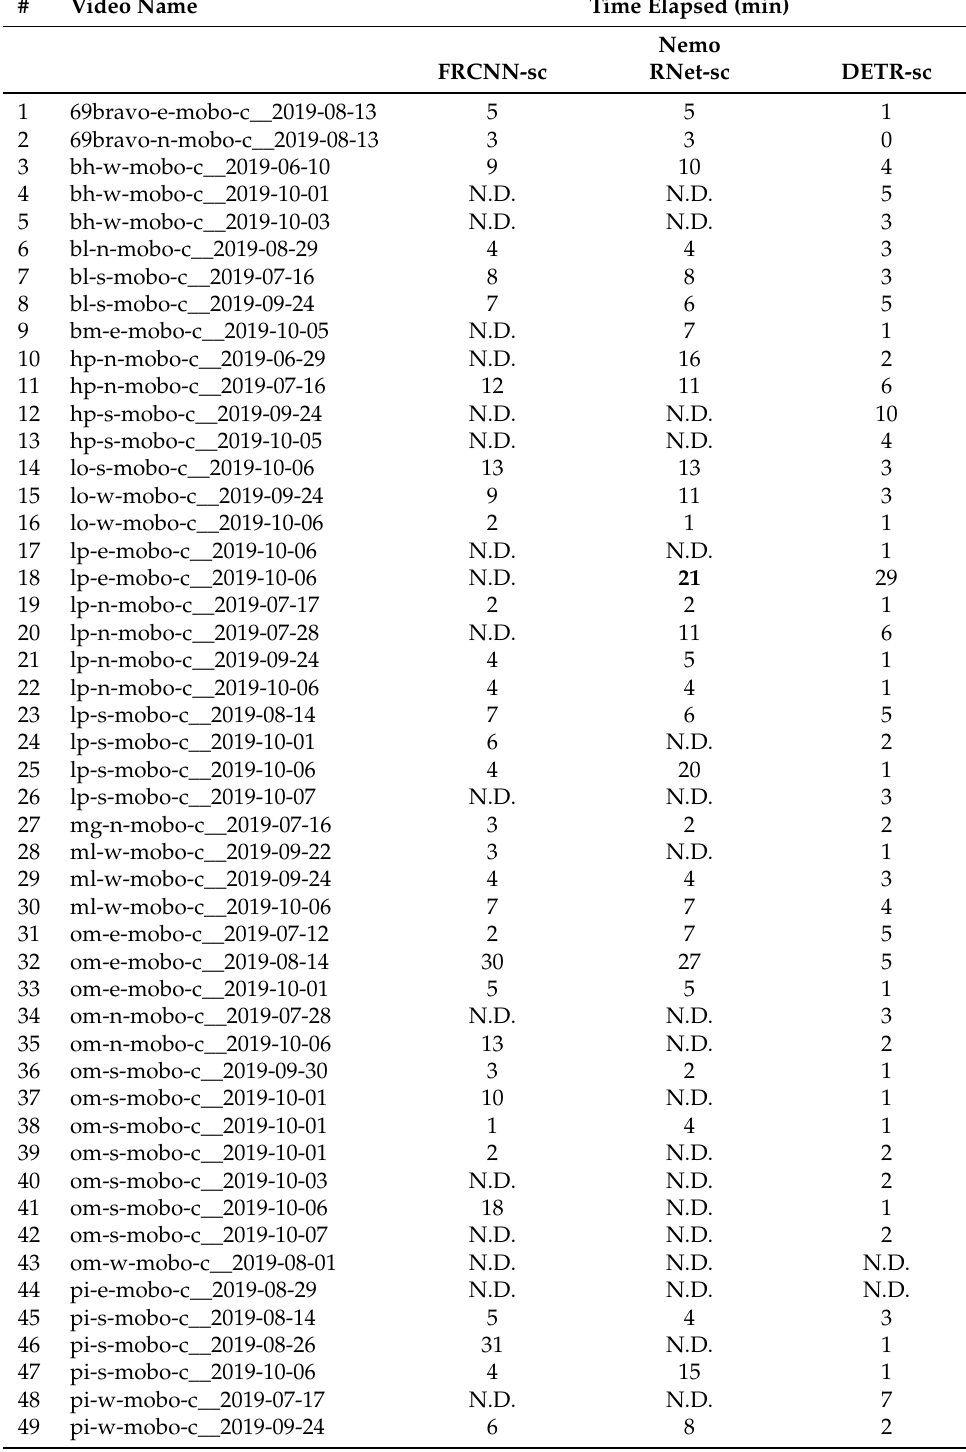
Table A1. The complete incipient-stage first smoke detection analysis. The first frame was used as the reference, which is 1 min after the start of the wildfire. Observations where either RNet-sc or FRCNN-sc detected smoke earlier than DETR-sc are marked in